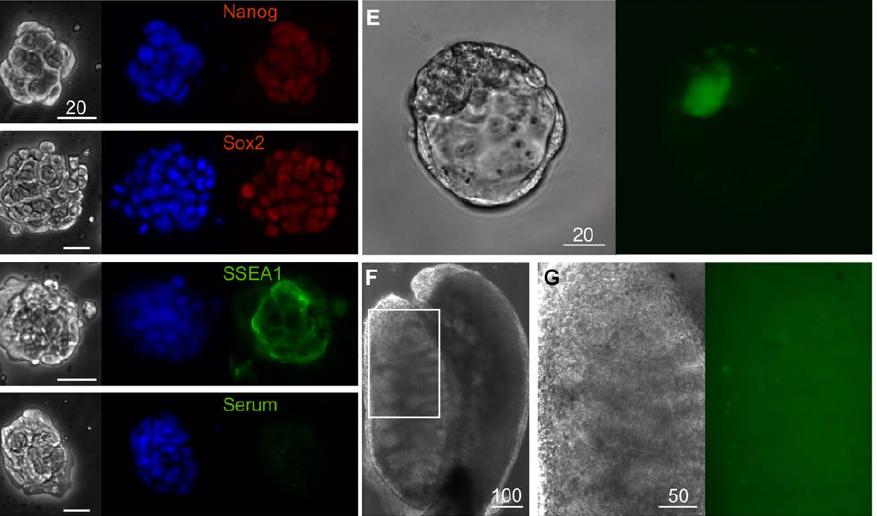
Figure 3. Mouse embryonic stem cells cultured under CDSF conditions are pluripotent. (A–D): Mouse ESCs cultured under CDSF conditions were immunostained (right) with either specific antibodies against Nanog (A), Sox2 (B) and SSEA1 (C), or normal mouse serum (D). Also, phase contrast (left), and DAPI-stained (middle) images of these mESCs are shown. Bars, 20 m m. (E): Phase contrast (left) and fluorescence (right) images of a chimeric blastocyst aggregated with the Oct3/4::EGFP mESC line. Bar, 20 m m. (F): A phase contrast image of a male gonad dissected from a chimeric E13.5 embryo. The rectangle indicates the area shown in G. Bar, 100 m m. (G): Enlarged phase contrast (left) and fluorescence (right) images of the male gonad shown in F. Bar, 50 m m.